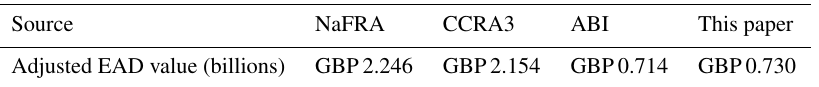
Table 3. Estimated annual damage values for previous modelled analyses (England’s National Flood Risk Analysis, NaFRA, and the UK’s Third Climate Change Risk Assessment, CCRA3), observed insured losses from the Association of British Insurers (ABI) and the new model analysis conducted for this paper. These figures represent direct financial losses due to fluvial, pluvial and coastal flooding in 2020 values for residential and non-residential properties in Great Britain.